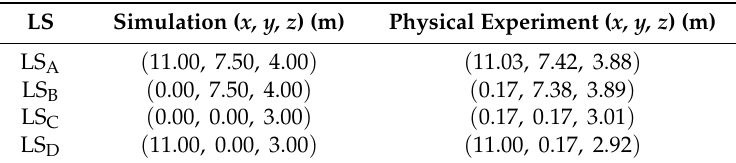
Table 2. Simulated extreme uncertainty values for AB and AD pairs.